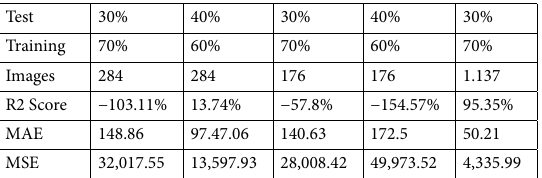
Table 2. Parameters changed to evaluate the accuracy of the CNN model—A549 cell